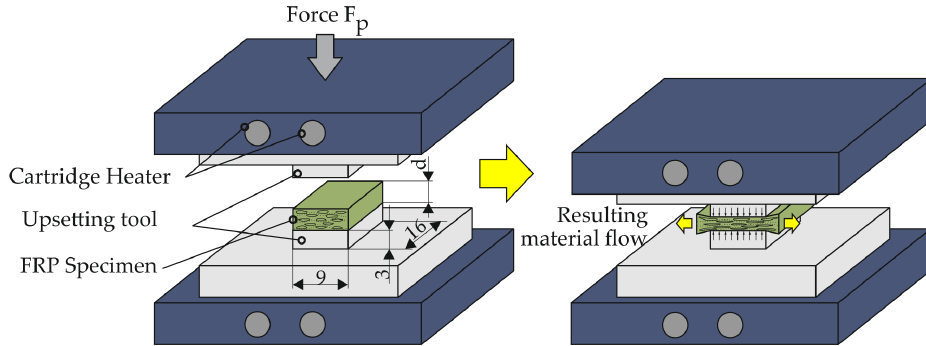
Figure 7. Schematic illustration of the process sequence of the plane-strain upsetting test. Table 2. Test specification for compaction specimens with the different